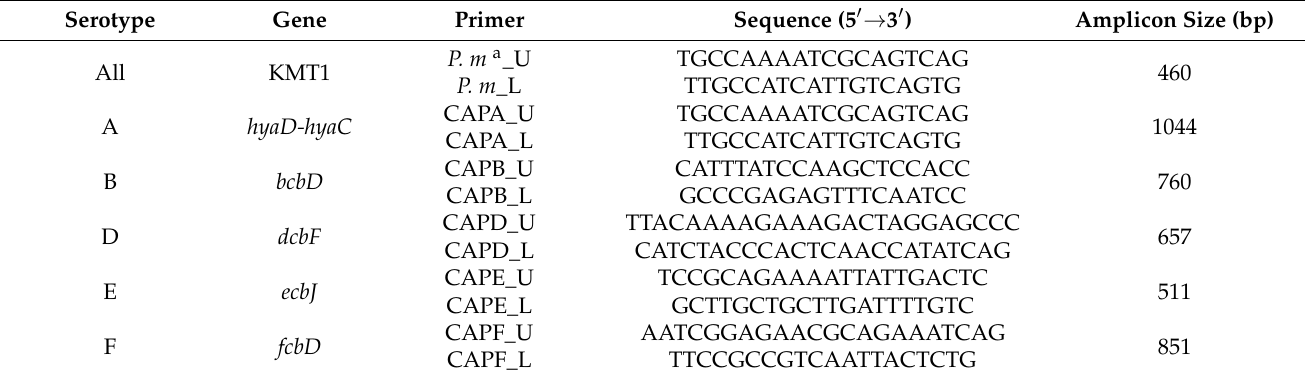
Table 4. Primers for the detection of capsular serotype of P.m [28].